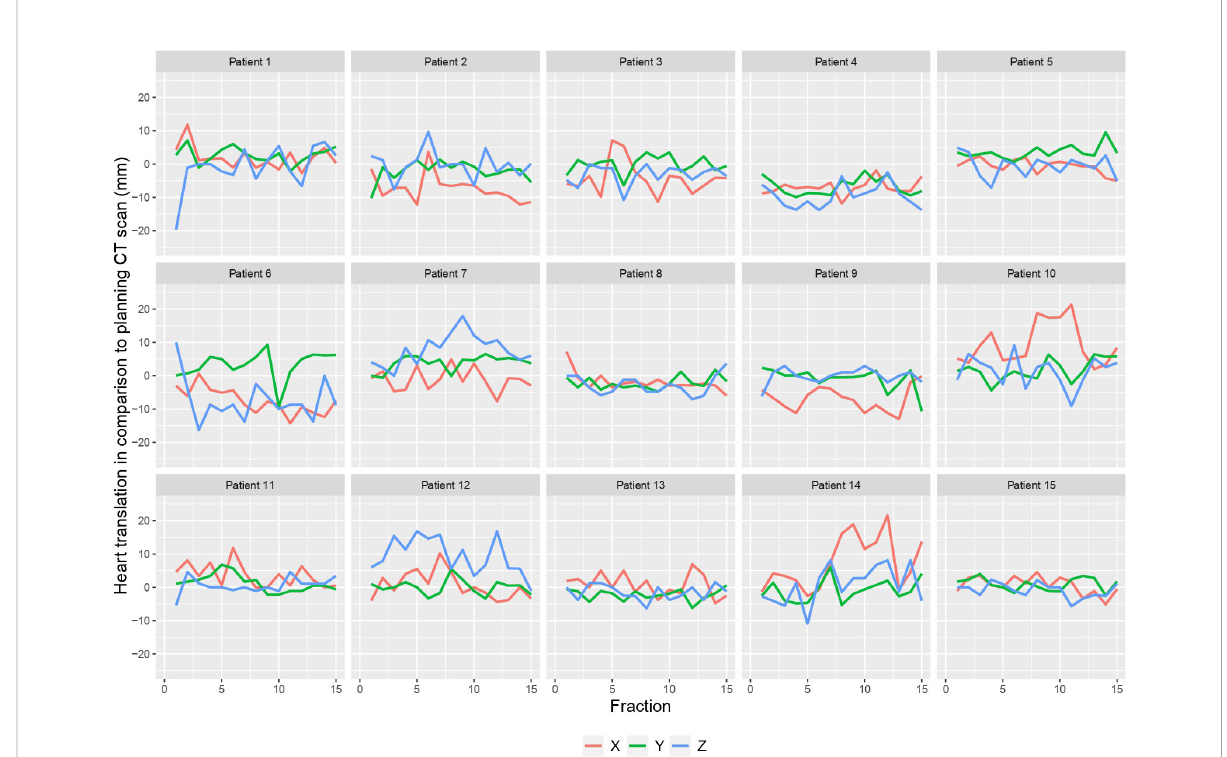
FIGURE 4 Heart translation per patient in each axis (X, Y, Z) in comparison to the planning CT